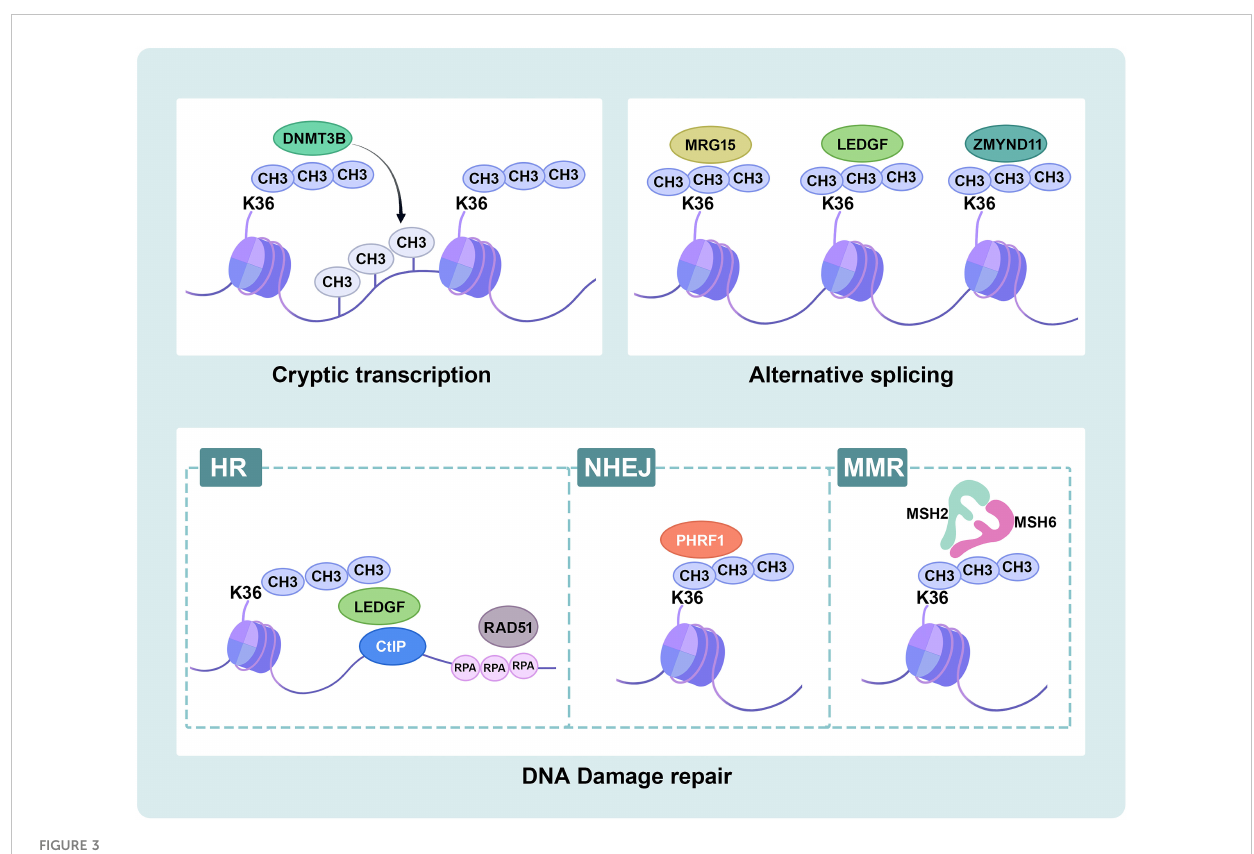
FIGURE 3 Schematic overview of SETD2 functions. SETD2-mediated H3K36me3 plays important biological roles in ccRCC. Cryptic transcription: SETD2- mediated H3K36me3 recruits DNMT3B to target intragenic DNA methylation. RNA splicing: SETD2-mediated H3K36me3 recruits splice factors MRG15, LEDGF and ZMYND11 to modulate alternative splicing events. DNA damage repair: SETD2-mediated H3K36me3 recruits LEDGF, and LEDGF binds CtIP at the break site to promote HR repair. SETD2-mediated H3K36me3 recruits PHRF1 to modulate NHEJ repair. SETD2-mediated H3K36me3 recruits hMutS a (hMSH2-hMSH6) to MMR repair. DNMT3B, DNA-methyltransferase 3B; MRG15, MORF4-related gene on chromosome 15; LEDGF, lens epithelium-derived growth factor; ZMYND11, Zinc fi nger MYND-domain containing 11; HR, Homologous recombination; CtIP, C- terminal binding protein interacting protein; RPA, replication protein A; NHEJ, non-homologous end-joining; PHRF1, plant homeodomain of Ring fi nger domains 1; MMR, mismatch repair; MSH2, MutS a homolog 2; MSH6, MutS a homolog